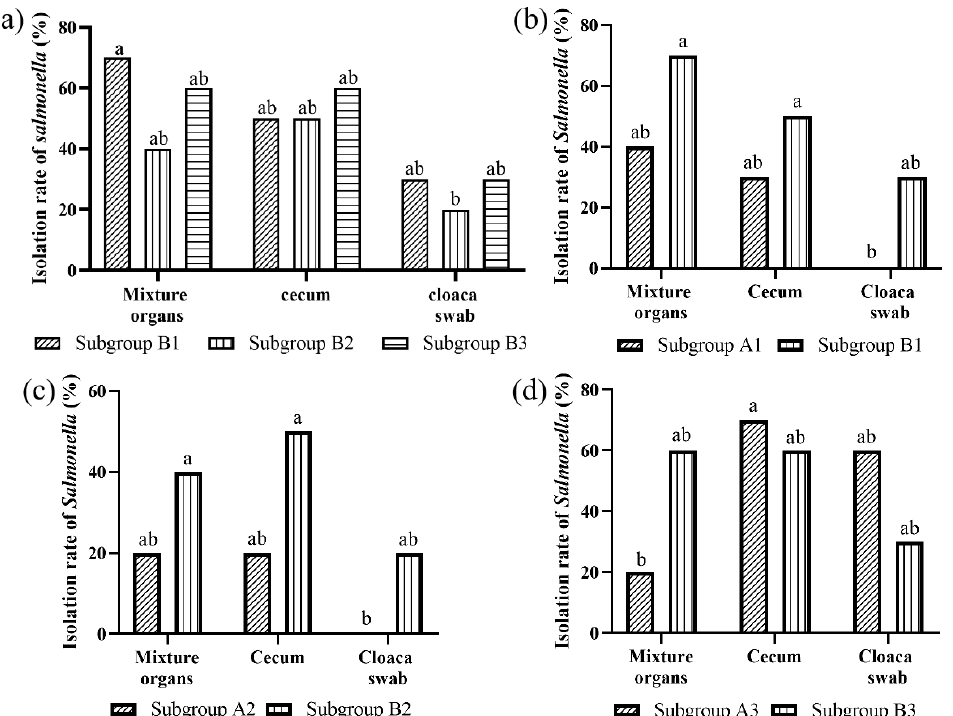
Figure 4. ( a ) The isolations of Salmonella from different samples of birds in challenged/untreated groups. ( b ) The isolations of Salmonella pullorum from different samples of birds in the Salmonella pullorum -challenged groups. ( c ) The isolations of Salmonella give from different samples of birds in the Salmonella give -challenged groups; ( d ) The isolations of Salmonella kentucky from different samples of birds in the Salmonella kentucky -challenged groups. The means with different letters denote a significant difference ( p < 0.05)